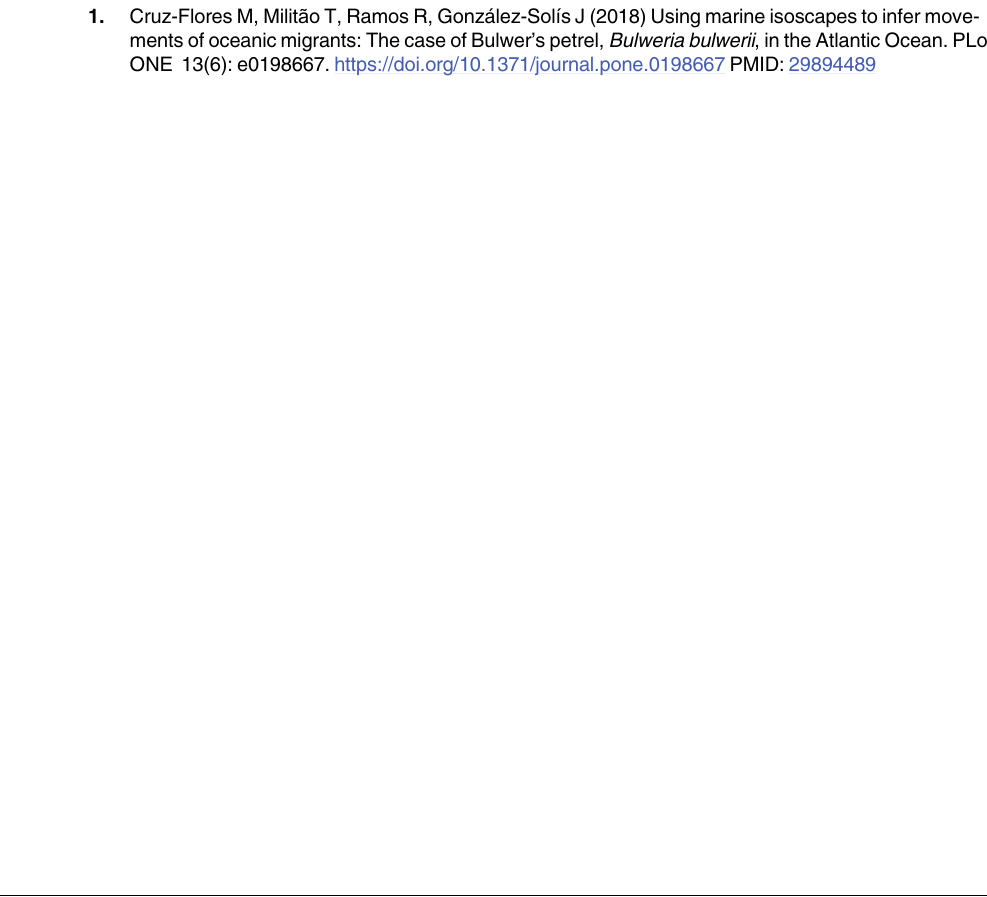
Correct classification rates (%) obtained using stable isotope analysis ( δ 15 N and δ 13 C values) for P1, S8 and R6 of Bulwer’s petrel tracked with geolocation, and validation of the discriminant analyses using the testing data. Discriminant functions obtained using δ 15 N and δ 13 C values of S8 and R6 to infer the non-breeding areas of Bulwer’s petrel. For each feather, the higher result (for the Central or South Atlantic) indicates the belonging of the bird to that